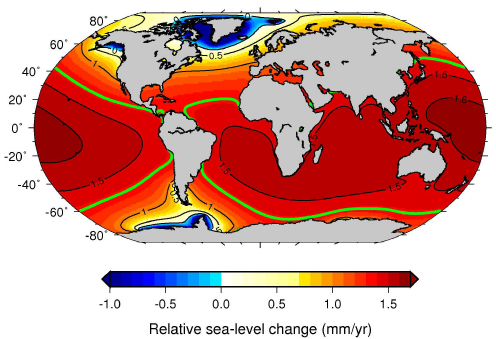
Fig. 4. The combined relative sea level variations for all ice masses. The thick green contour indicates the global average eustatic RSL (1.4mmyr − 1 )